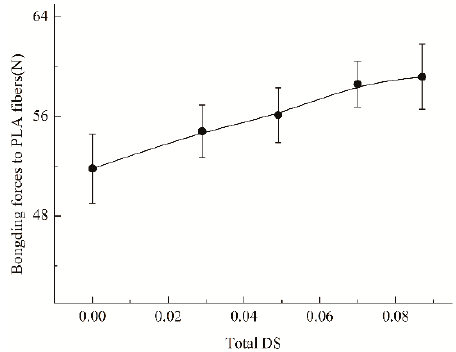
/ caproylation on adhesion of starch to PLA Figure 4. Impact of hydroxypropylsulfonation/caproylation on adhesion of starch to PLA fibers. Figure 4. Impact of hydroxypropylsulfonation